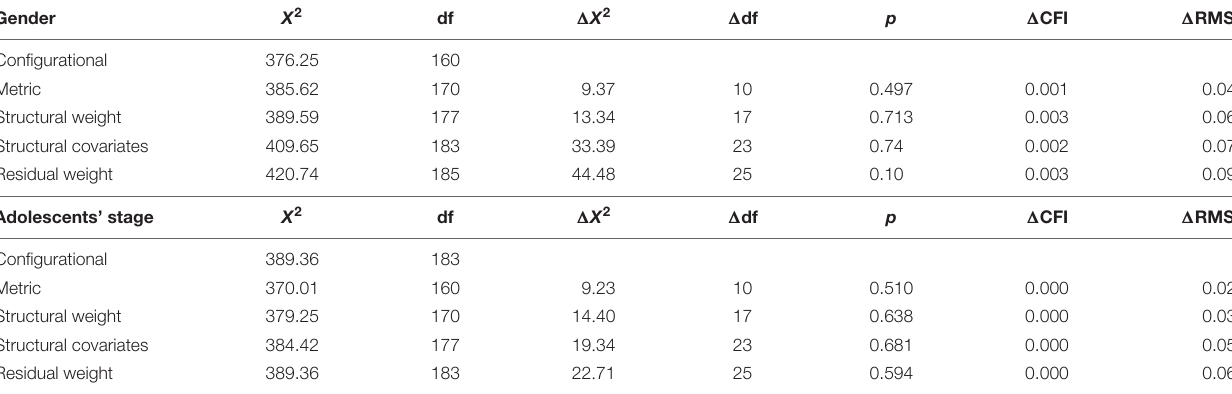
TABLE 4 | Results of the invariance of structural model by gender and stage of